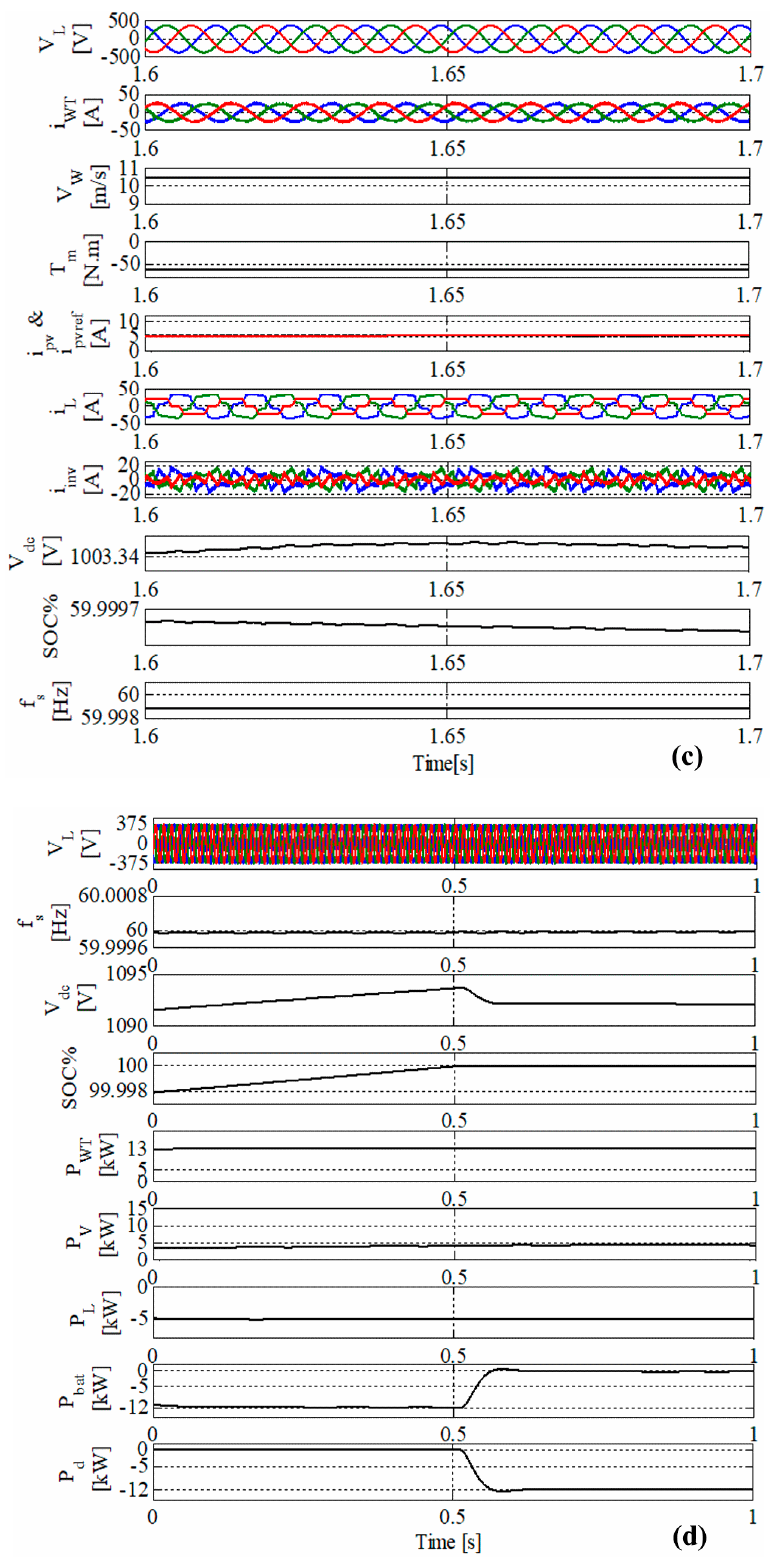
Figure 13. Dynamic performance off-grid configuration based on SPVA, WT, and DG under ( a ) variation of wind speed with greater than 50%, ( b ) balanced nonlinear load, ( c ) unbalanced nonlinear load, and ( d ) when SOC% equal to 100%.